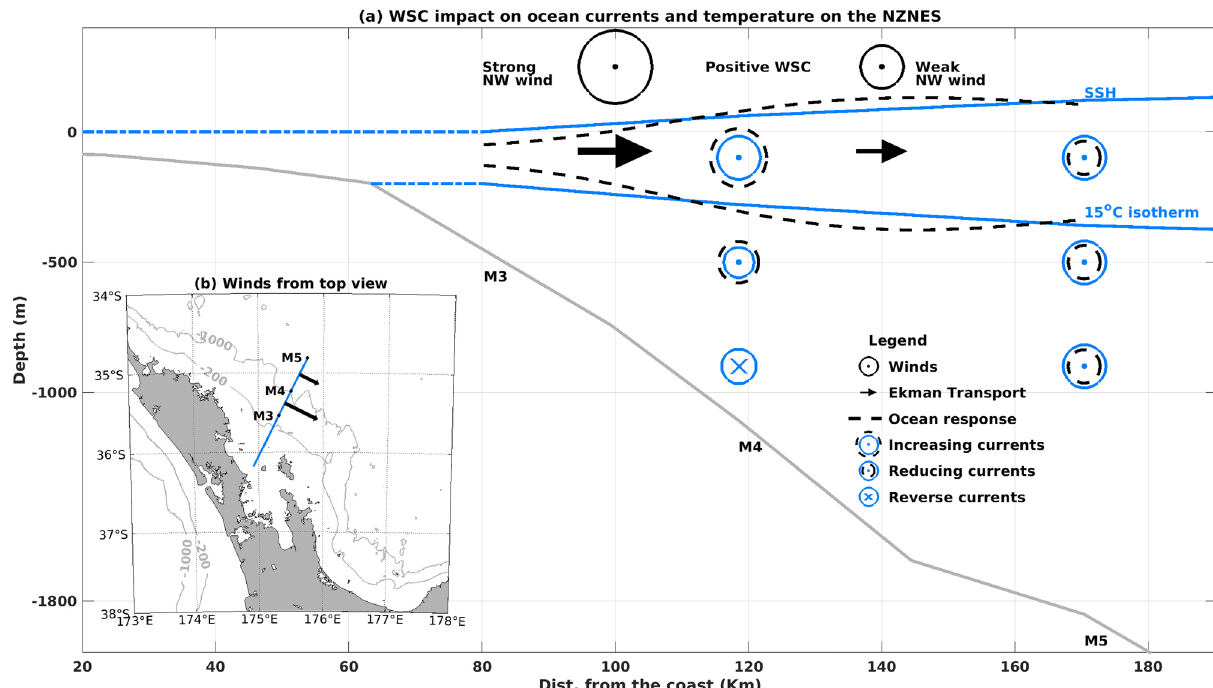
Figure 9. ( a ) Schematic of the WSC forcing on the time mean SSH, 15 ◦ C isotherm and currents. The upper (lower) blue line represents the SSH ( 15 ◦ C isotherm) time mean. The black dashed lines represent the SSH and 15 ◦ C isotherm responses to the positive WSC forcing. The dashed blue lines represent regions not studied in detail in the present work. ( b ) Top view of the schematic wind field near the moorings. The map was generated with m_map (http:// www. eos. ubc. ca/